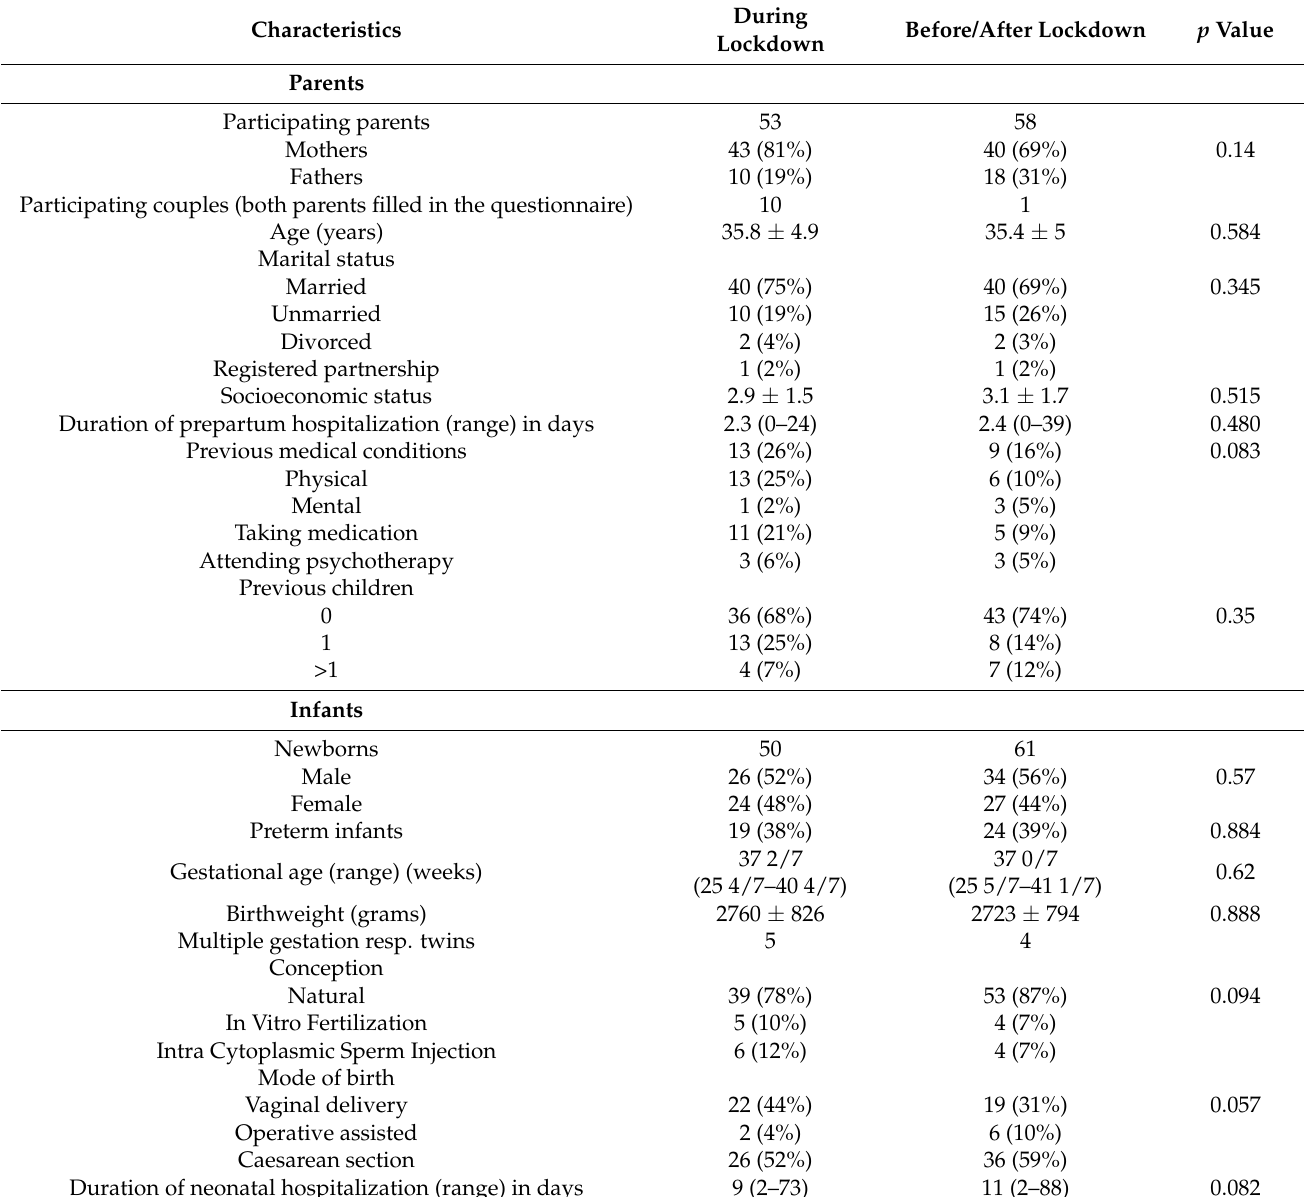
Table 1. Baseline characteristics of 104 parents and 103